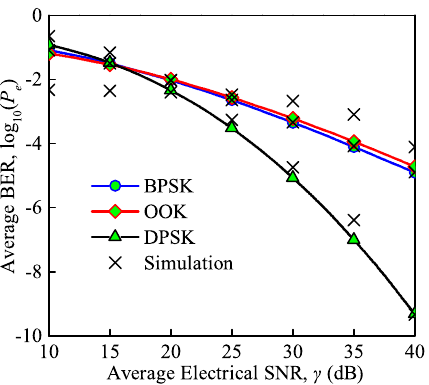
Figure 9. Average BER versus average electrical SNR under different modulation schemes ( C 2 n = 0.75 × 10 − 14 m − 2/3 for moderate turbulence, λ = 850 nm, T e = 300 K, R b = 0.155